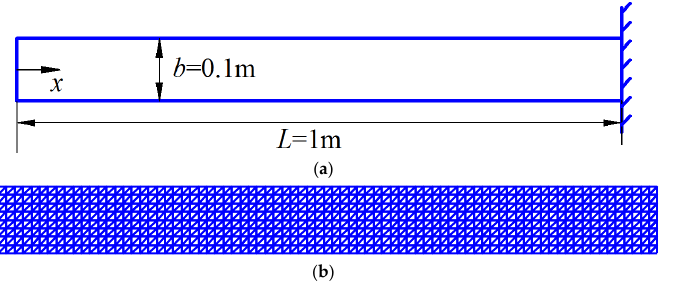
Figure 3. The description of the scalar wave propagation in a clamped-free elastic bar: ( a ) geometric shape of the elastic bar; ( b ) employed uniform triangular mesh. The computed velocity distributions of this elastic bar were employed to investigate this simple transient wave propagation problem. For the nondimensional temporal dis- cretization step CFL = 0.1 and the considered time point t = 0.6 s, the calculated velocity distributions of this elastic bar from various numerical approaches together with the ex- act solutions are displayed in Figure 4. It is seen from the figure that the numerical solu- tion from the standard FEM was not sufficiently accurate, and many unwanted peaks can be found in the solutions. In contrast to the standard FEM, the EFEM-N3 and EFEM-N9 are able to generate more accurate solutions despite several relatively small spurious peaks that can still be seen in the solutions. Among all of the considered nu- merical approaches, the numerical performance of the proposed EFEM-N6 is the best, since the resultant numerical solutions of the velocity distributions agreed very well with the exact solutions, and almost no spurious peaks can be seen in the solutions.